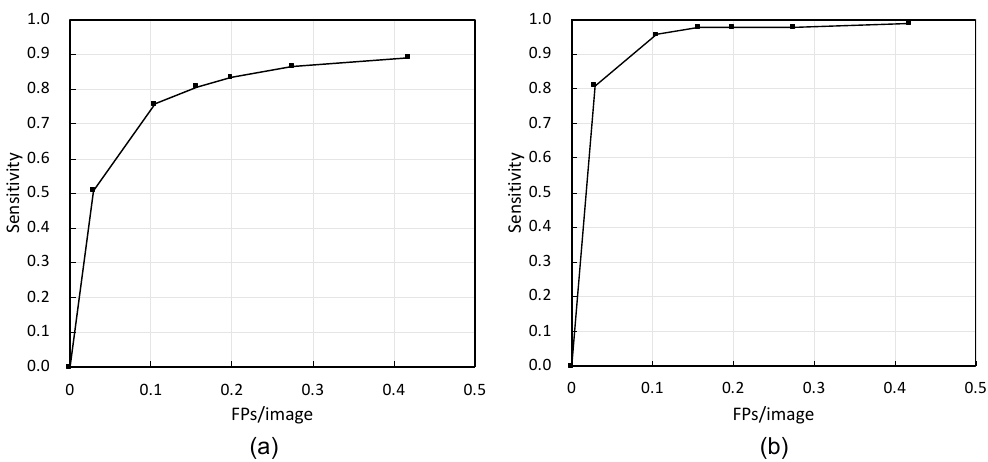
Figure 4. Free-response receiver operator characteristics (FROC) curves of ( a ) image-based evaluation and ( b ) lesion-based evaluation.